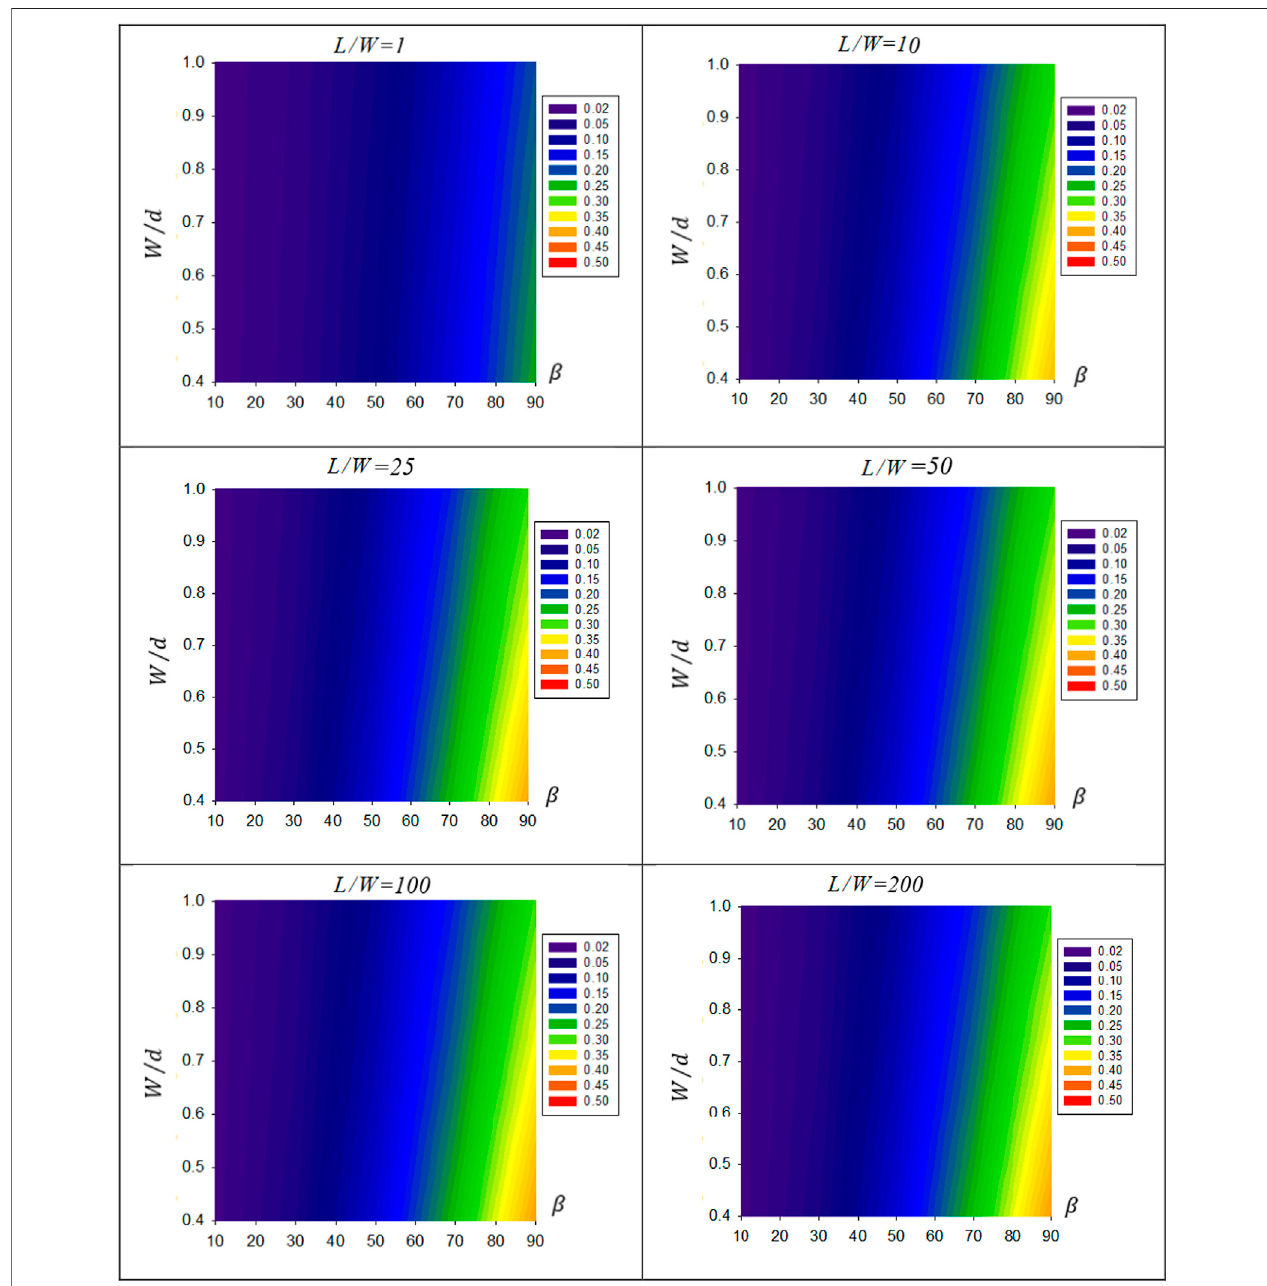
FIGURE 6 | Contour representation of F A